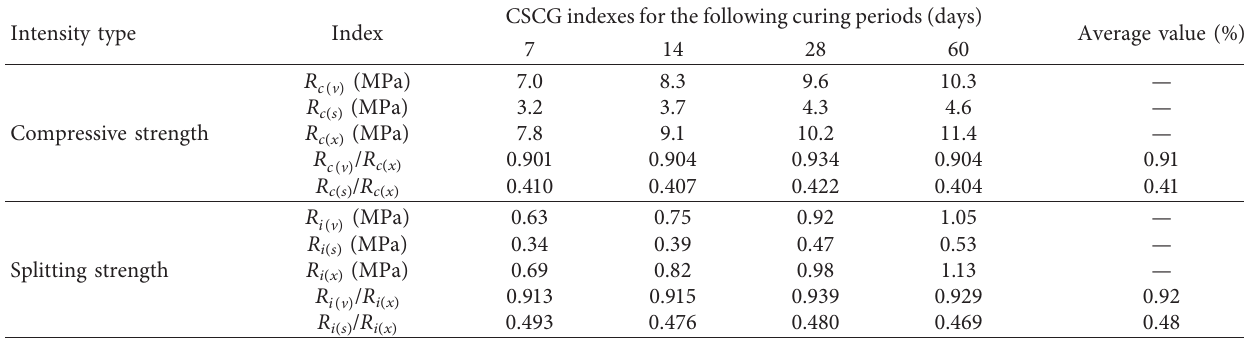
Figure 3: Change in gradation before and after compaction. (a) GM gradation; (b) XM gradation. Table 5: Strength of field core samples and specimens formed by VVTM and